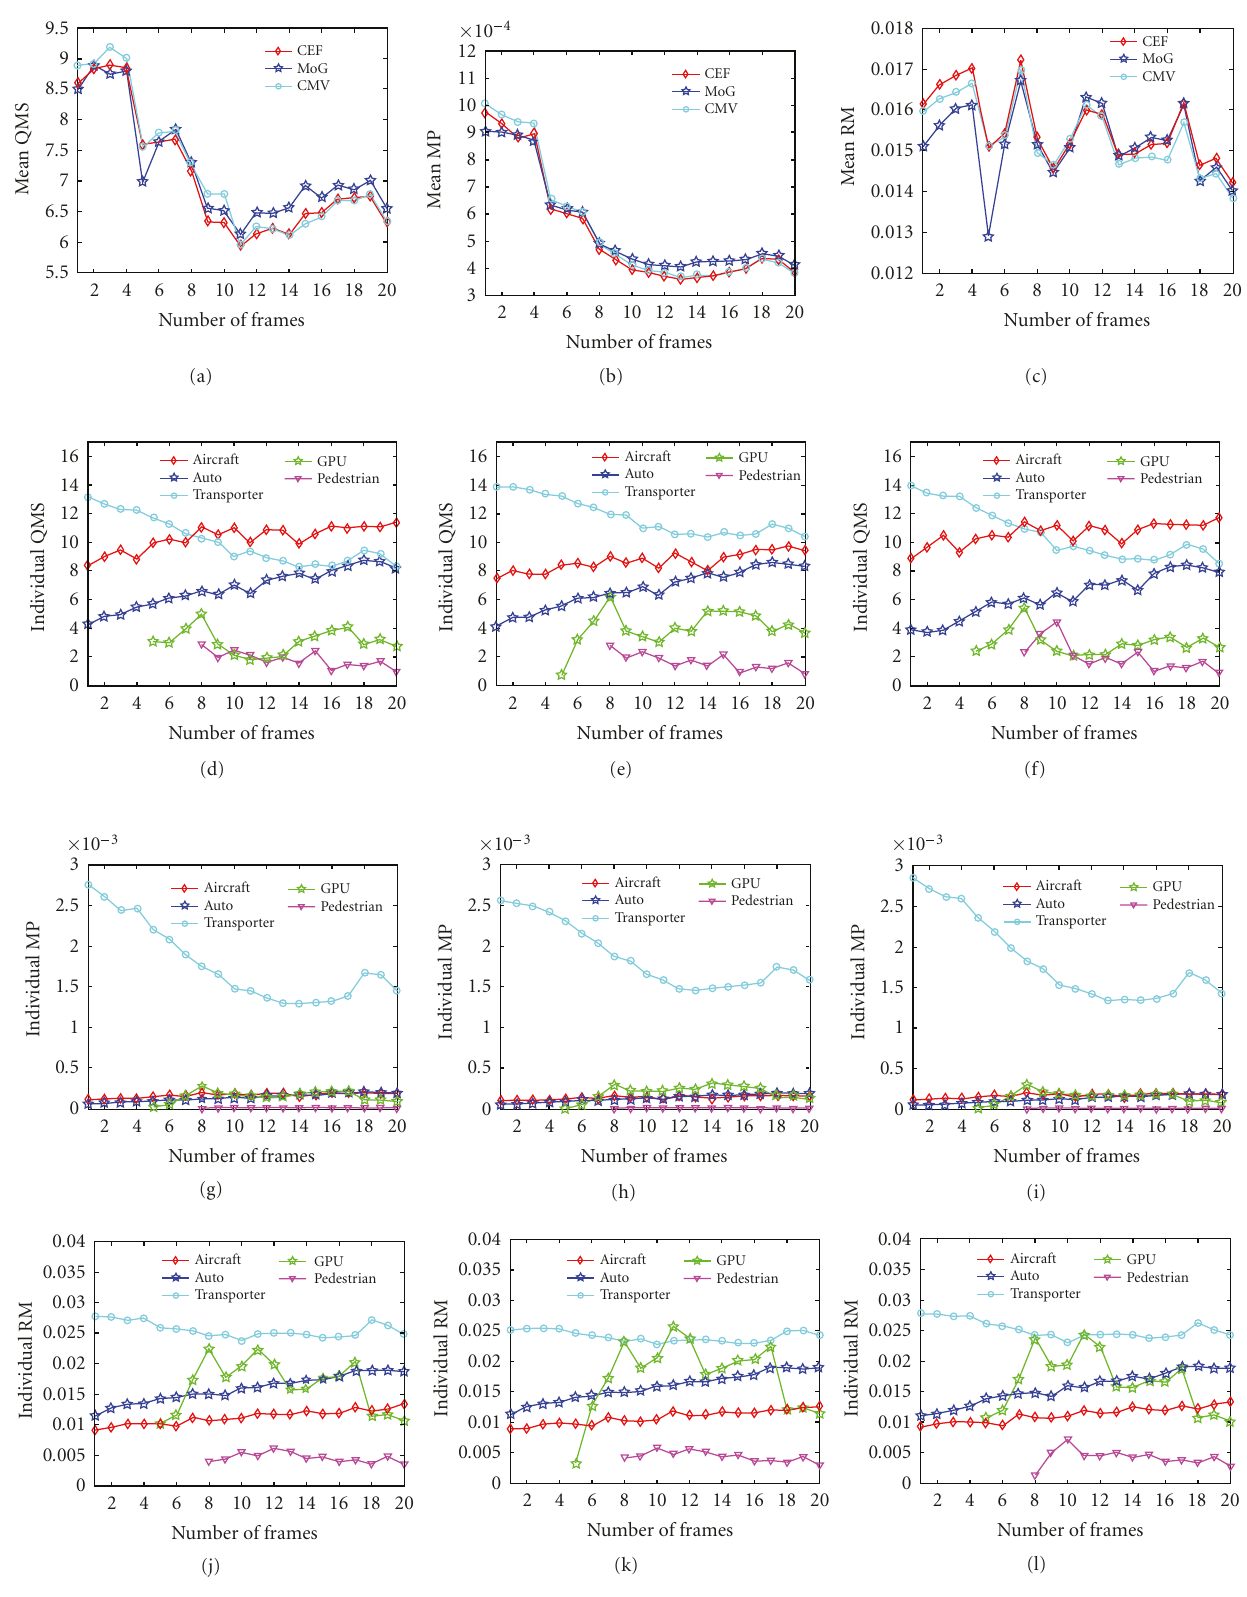
Figure 13: Average and individual object segmentation errors for Dataset S21; (a), (b), (c) average QMS, MP, and RM object-based seg- mentation errors of the motion detectors; (d), (e), (f) QMS individual object segmentation error of CEF, MoG, and CMV; (g), (h), (i) MP individual object segmentation error of CEF, MoG, and CMV; (j), (k), (l) RM individual object segmentation error of CEF, MoG, and